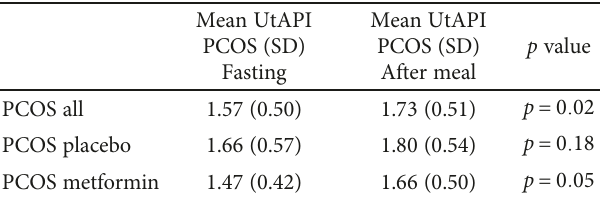
Table 4: At inclusion ( fi rst trimester) UtAPI was measured after an overnight fasting period, then 2 hours later after ingesting the study medication and a